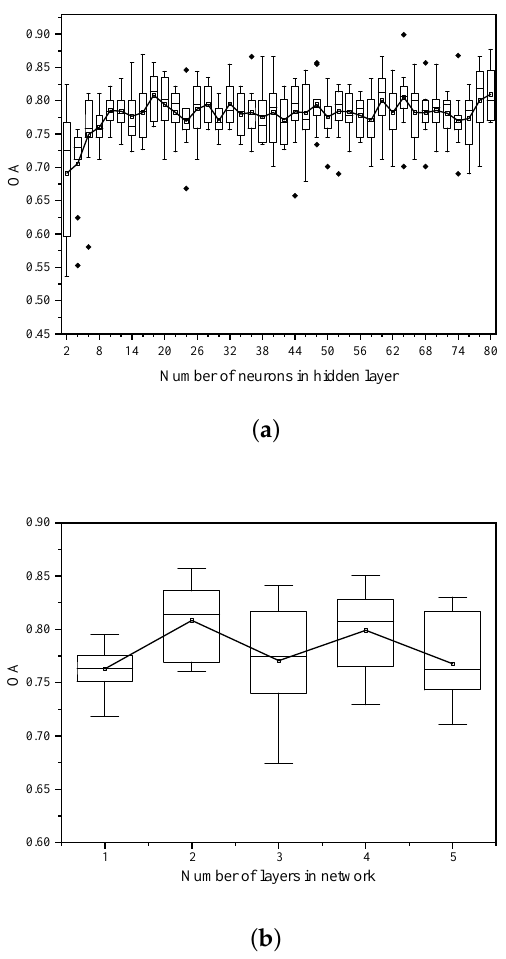
Figure 8. ( a ) The relationship between classification performance and the number of hidden layer neurons; ( b ) is the relationship between classification performance and the number of layers in the